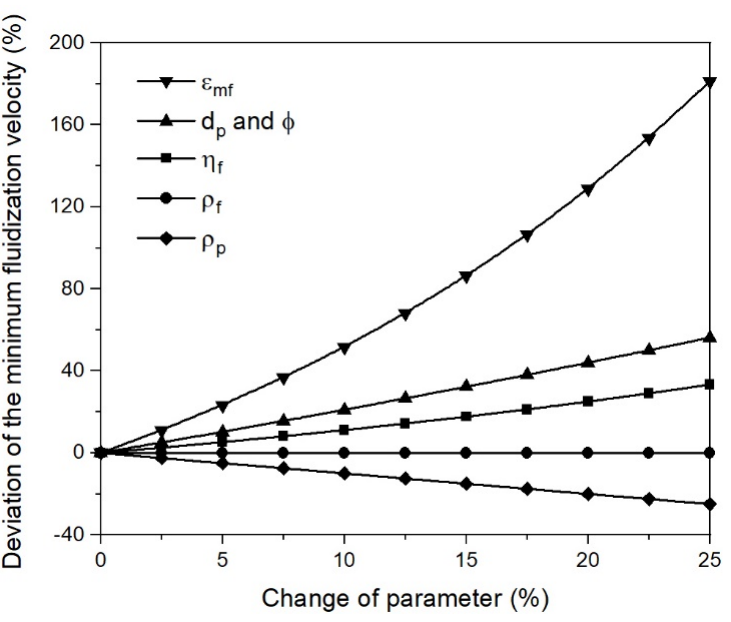
Figure 8. Sensitivity analysis of u